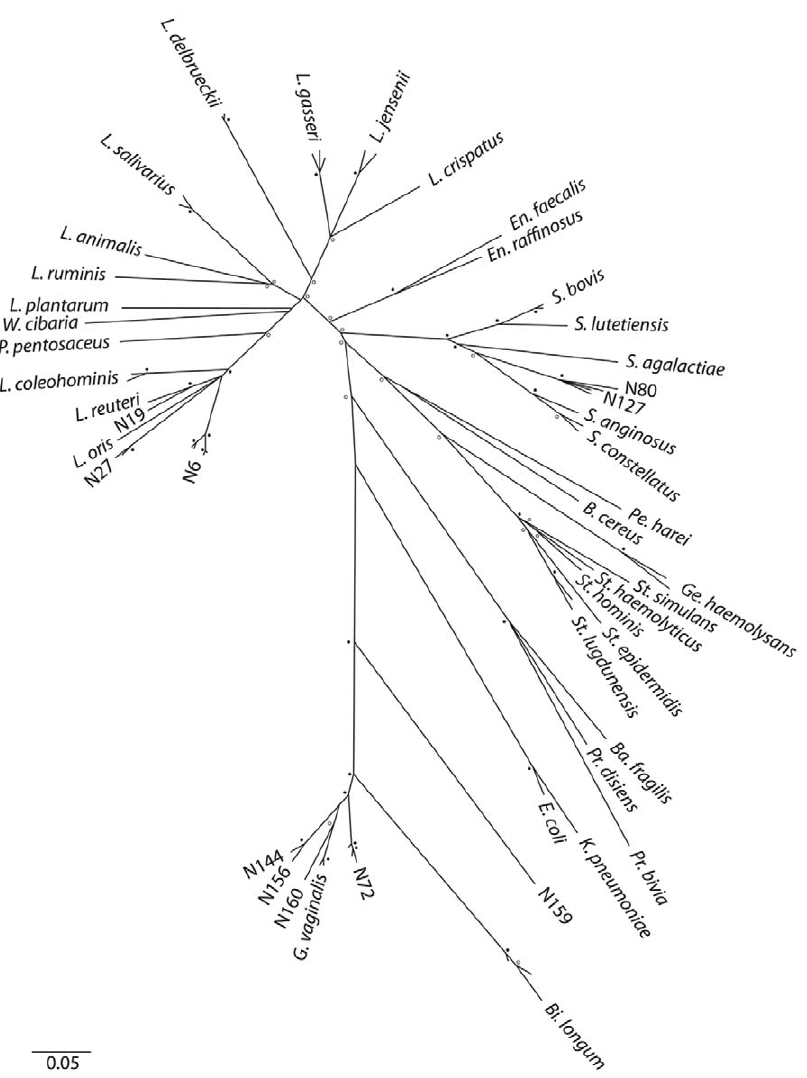
Figure 7. Phylogenetic relatedness of 149 isolates. Phylogeny of 149 isolates based on cpn 60 UT sequence. Branch length indicates estimated phylogenetic distance (sum=7.35, bar=0.05). Bootstrap values greater than 50% are indicated with circles, based on 1000 replicates (Mega 4.0). N=Nairobi isolate, L. = Lactobacillus , P.=Pediococcus, En.=Enterococcus, S.=Streptococcus, B. = Bacillus, Ge.=Gemella, St.=Staphylococcus, Ba.=Bacteroides, Pr. = Prevotella , E. = Escherichia , K. = Klebsiella , Bi.=Bifidobacterium, G .= Gardnerella .